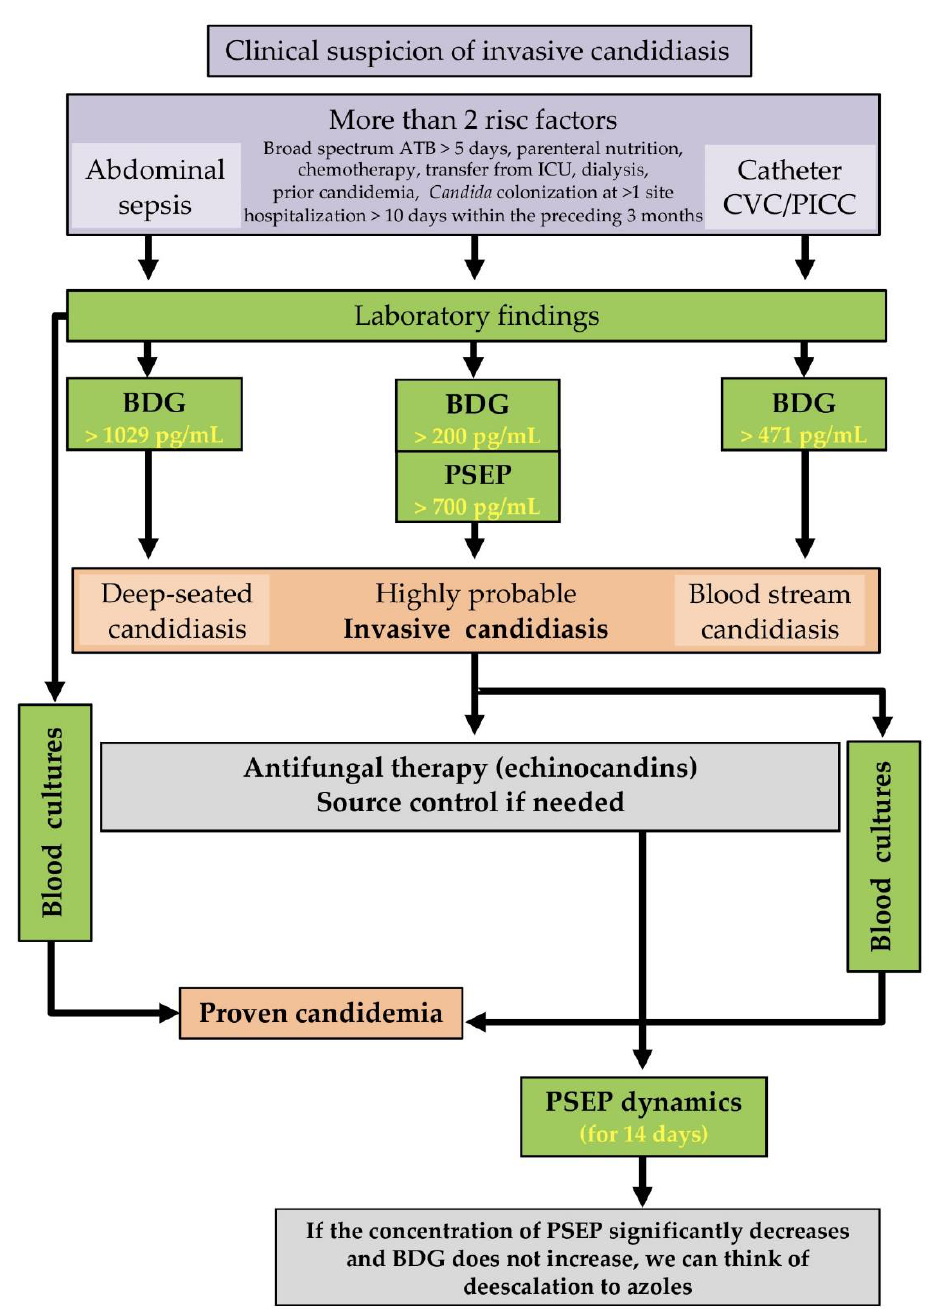
Figure 4. Use of PSEP and BDG serum concentration data in a diagnostic algorithm for non-neutropenic and non-transplanted ICU patients at risk of IC and/or candidemia. BDG, 1,3- β -D-glucan; PSEP, presepsin; BSC, bloodstream candidiasis (candidemia); DSC, deep-seated candidiasis; CS, catheter sepsis; Abdominal sepsis refers to an anastomosis leak, postoperative abscess, repeated surgery for recurrent abdominal sepsis, or infected